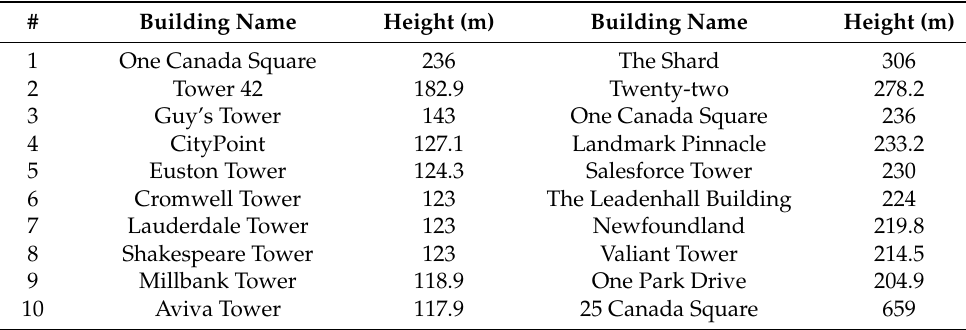
Figure 7. London in 2000 and 2020. Table 17. London’s 10 tallest skyscrapers in 2000 and 2020.